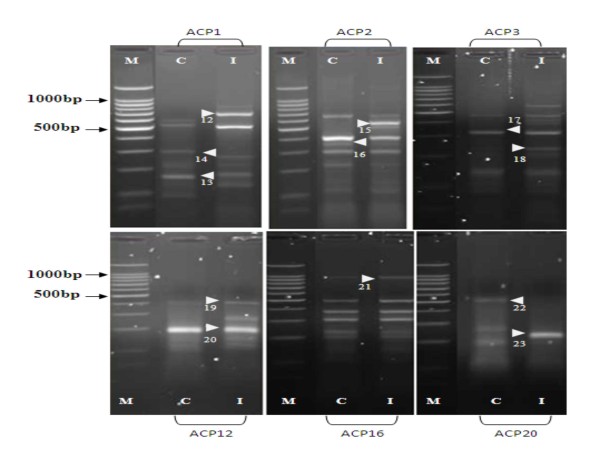
There are 12 bands, of which 6 of them are up regulated and 6 down regulated. The identities of these bands are presented in Table 4. M: 100 bp molecular marker; C: Control MDCK cell; I: MDCK cells infected with H5N1. Arrow indicates differential cDNA bands and each number indicates the DEG number.